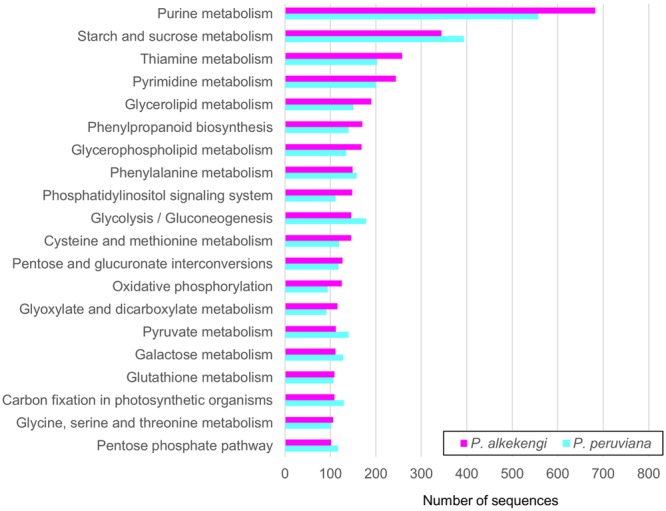
Pathway enrichment analysis of assembled unigenes in Physalis. Annotated unigenes were classified into 134 and 139 KEGG pathways in P. alkekengi and P. peruviana, respectively. The top 20 pathways including unigenes in P. alkekengi and the corresponding pathways in P. peruviana are displayed.